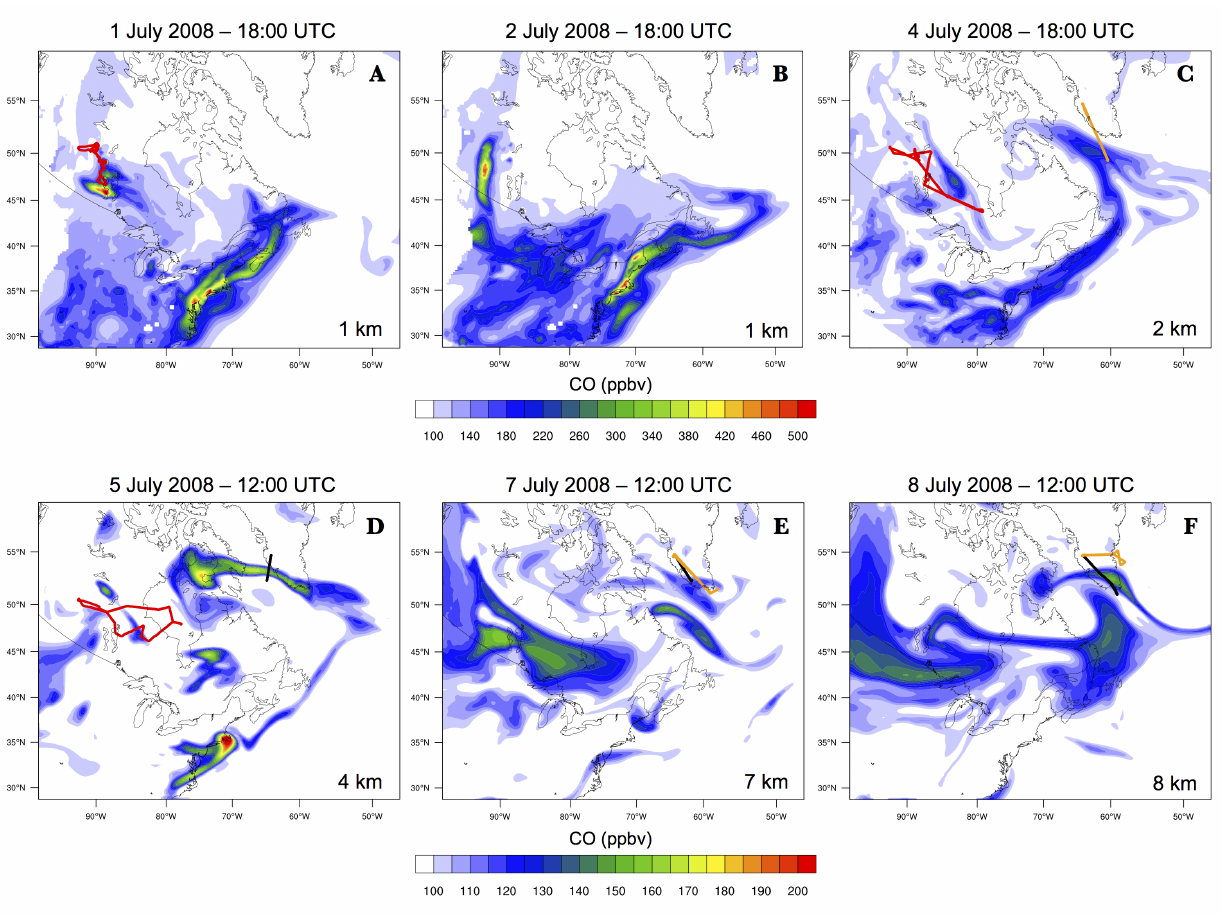
Fig. 2. Maps of pollution plumes, as indicated by model-predicted CO concentrations above 100ppbv, between 1 July and 8 July. DC8 flight tracks are shown in red, ATR-42 flight tracks are shown in black, and Falcon-20 flight tracks are shown in orange.